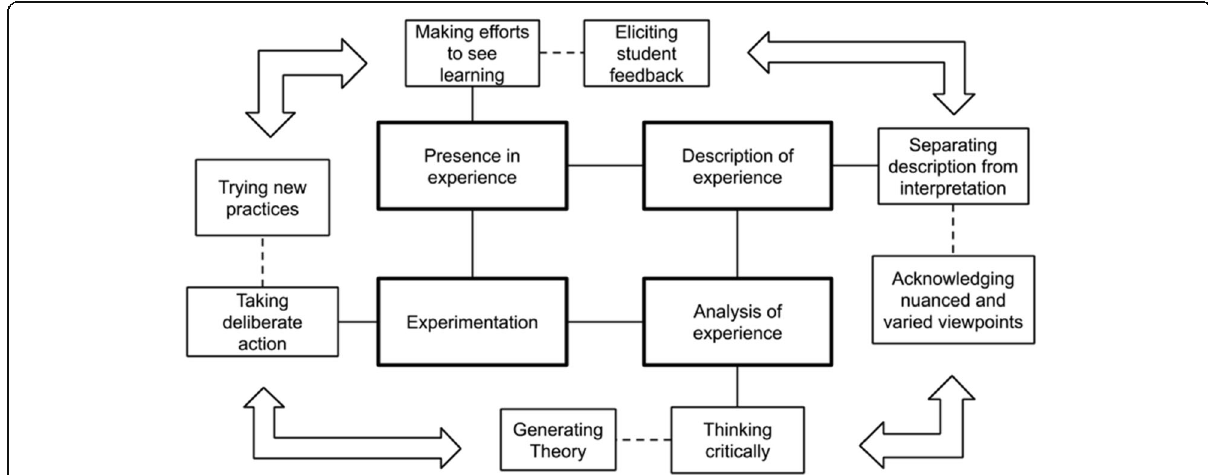
Fig. 2 The expanded version of Rodgers ’ (2002b) cycle of reflection. The original phases are bolded and additional actions within each phase, from the existing literature, are included in the branching